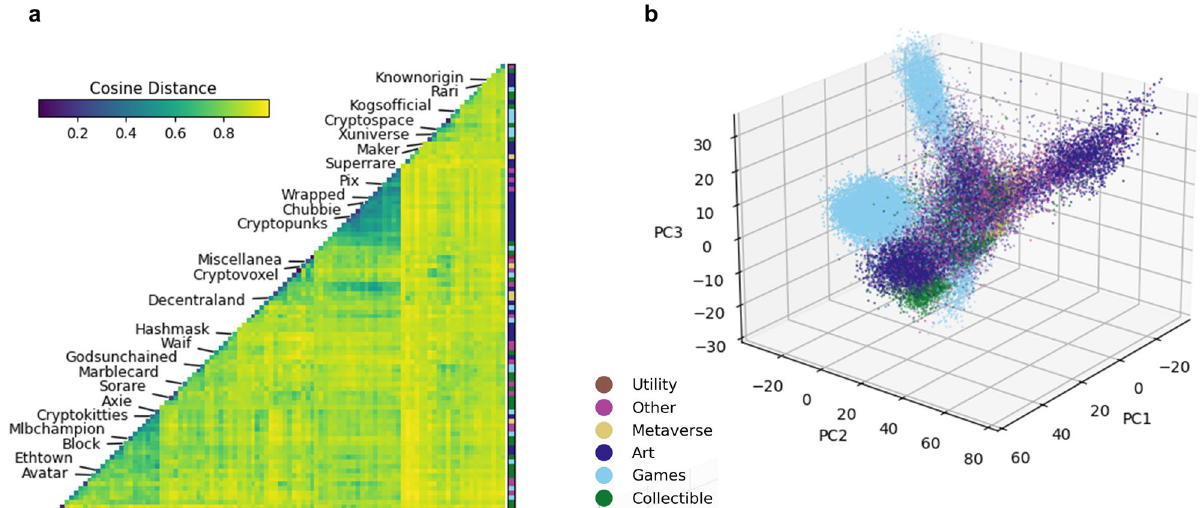
Figure 6. Visual features representation. ( a ) Cosine distance of graphical digital objects between items grouped by collections and categories (coloured bands on the right), recognising aesthetical similarities and uniformity between and within these groups. For visualization purposes, we selected the largest 98 collections in our dataset. ( b ) The dimensionality reduction of AlexNet vectors by PCA and their visualization in the PC1, PC2 and PC3 space, broken down by NFT categories, demonstrate the presence of graphically uniform clusters. For visualization purposes, we downsampled the digital objects associated with the CryptoKitties and Sorare collections, which alone constitute the 61% of the whole